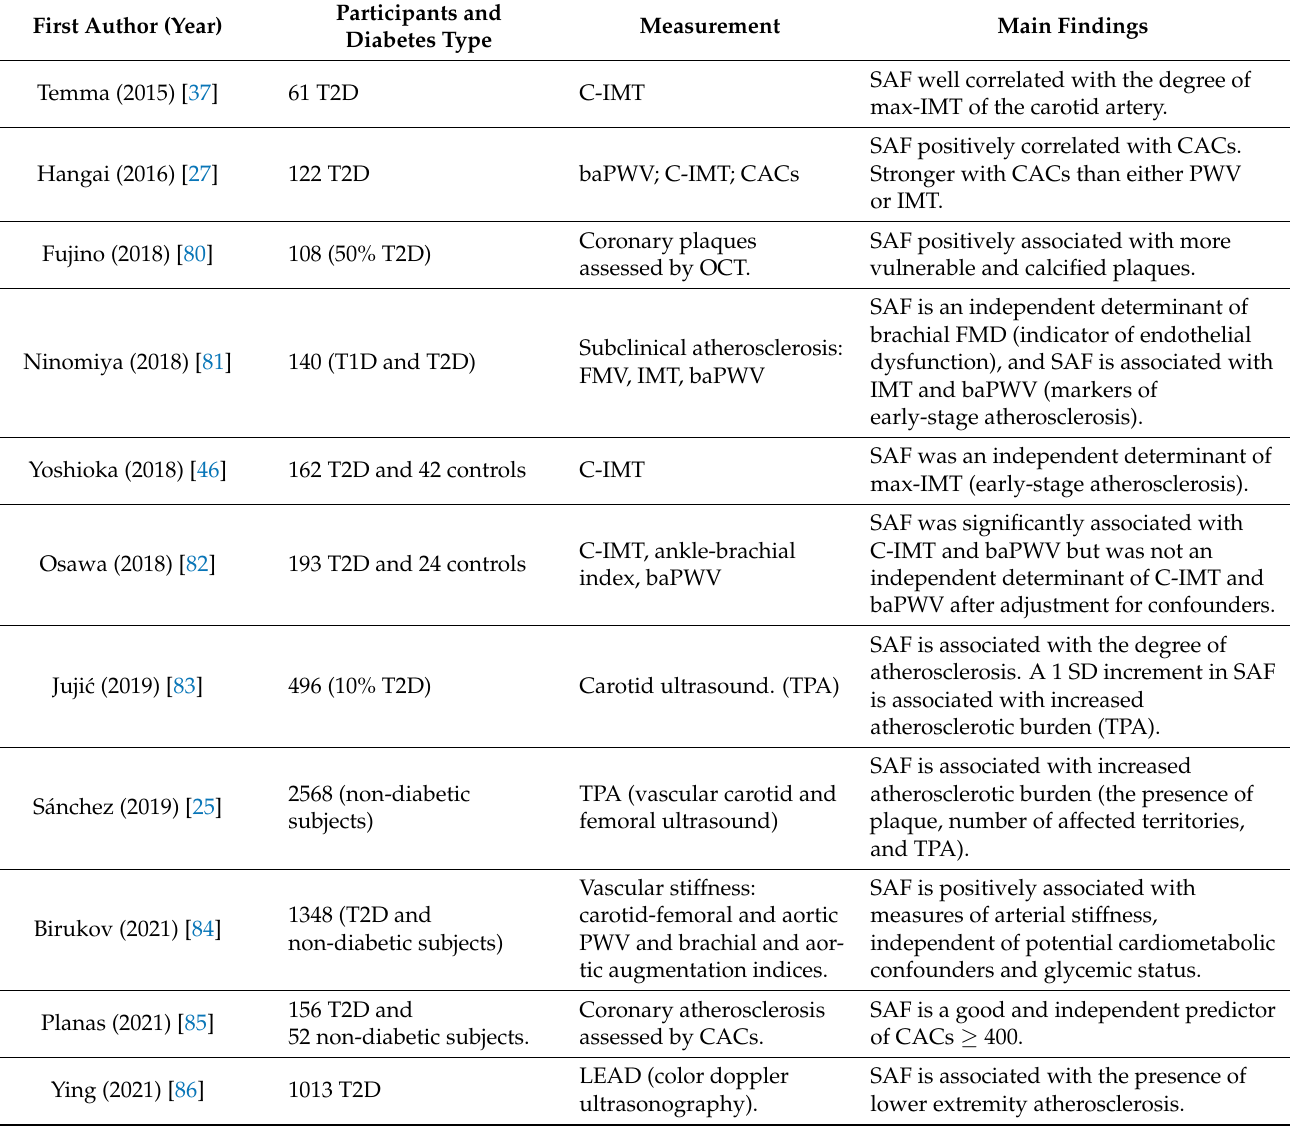
Table 1. SAF as a biomarker of the presence of subclinical cardiovascular